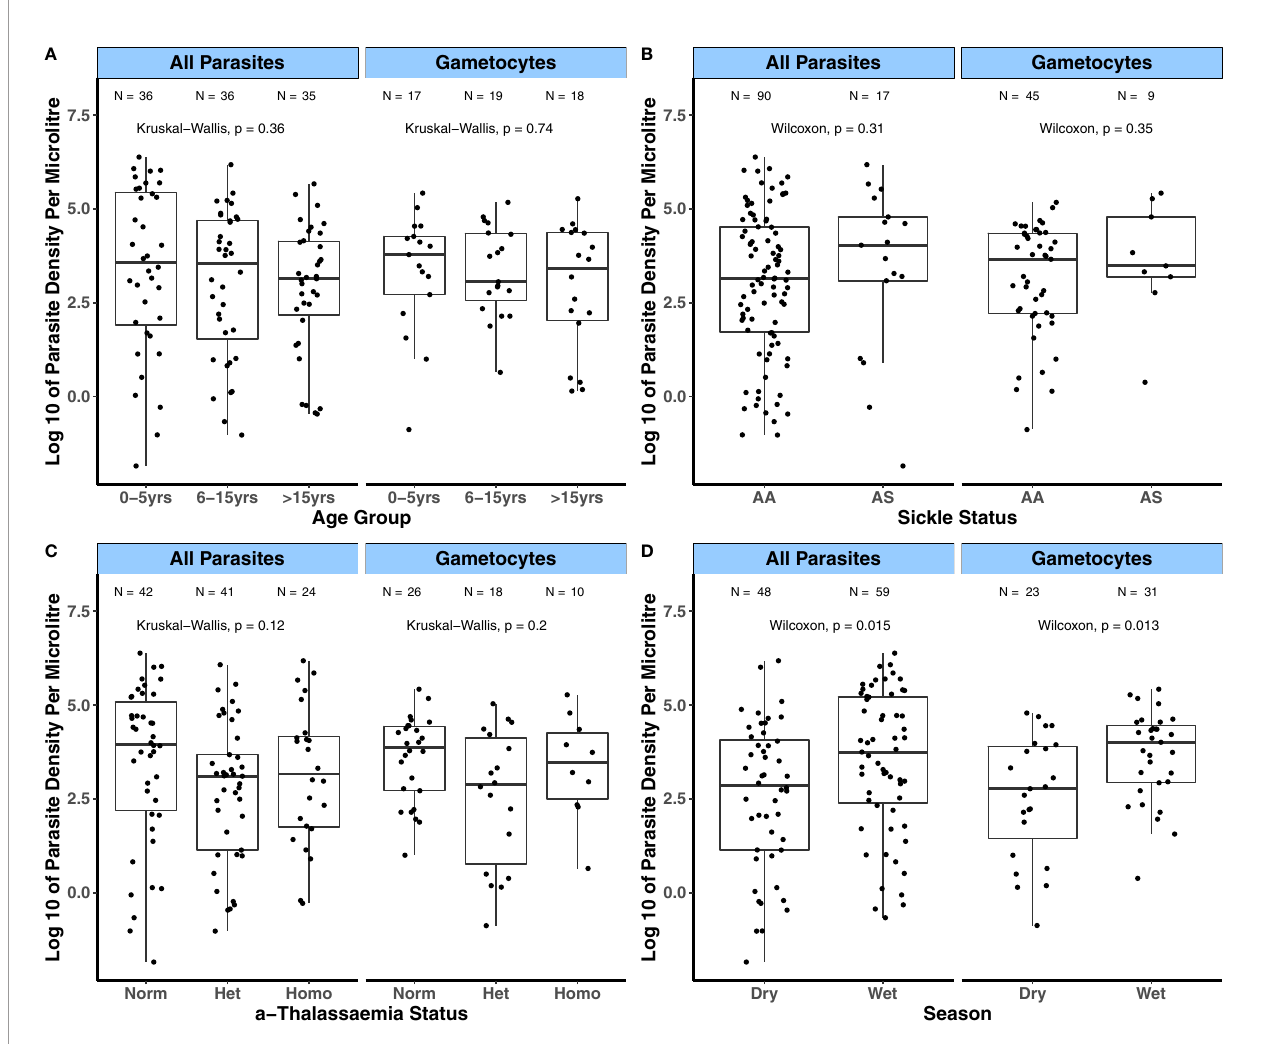
FIGURE 2 | Variation in sub-patent parasite densities by factors associated with gametocyte carriage in the AFIRM cohort. Asexual parasite and gametocyte densities by (A) Age group; (B) Sickle genotype; (C) a -thalassaemia genotype; and (D) Season with parasitaemia detected by 18S NASBA (all parasites) and Pfs25 NASBA (female gametocytes). Comparisons were carried out using the Wilcoxon test and Kruskal-Wallis test. The number of parasite positive individuals (N) is indicated at the top of each graph. a -thalassaemia: Norm – normal, Het – heterozygous, and Homo – homozygous. The boxes of boxplots display the median bound by the fi rst and third quartiles, with the whiskers depicting the lowest and highest values (excluding outliers). The dots indicate individual data magnitude of antibody responses to all antigens. Gametocytaemia,